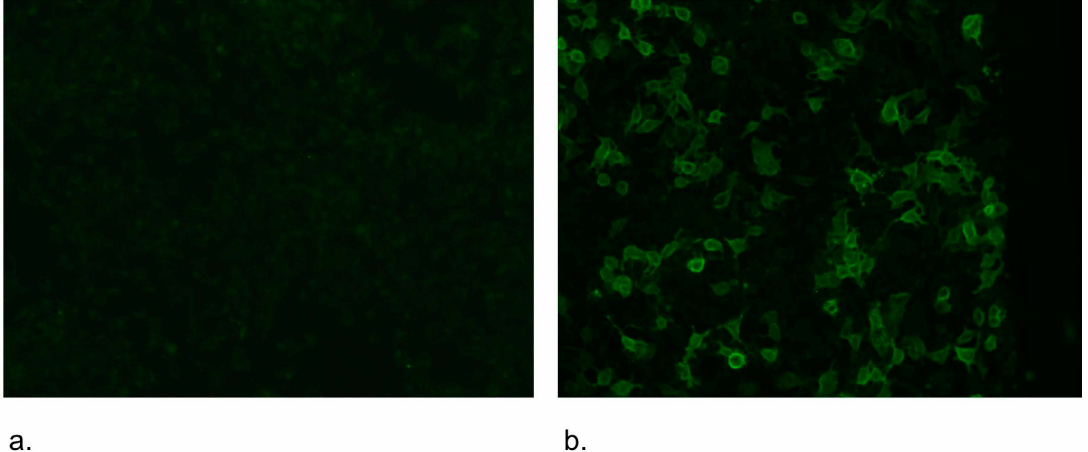
Figure 4. Immunofluorescence staining for aquaporin-4 in a cell-based assay: ( a ) negative stain; ( b ) positive stain. Images from the collection of Division of Neurochemistry and Neuropathology, Department of Neurology, Poznan University of Medical